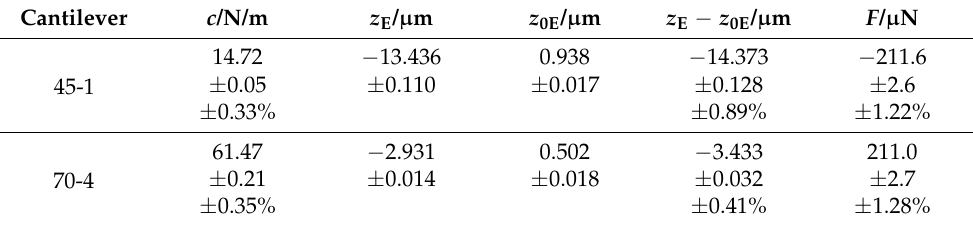
Table 7. The determination of the stylus force from the stiffness and the zero-load bending, as shown in Equation (6). The error of c is the standard deviation, the estimation of errors of z E and z 0 E is described in Section 4.2.1.